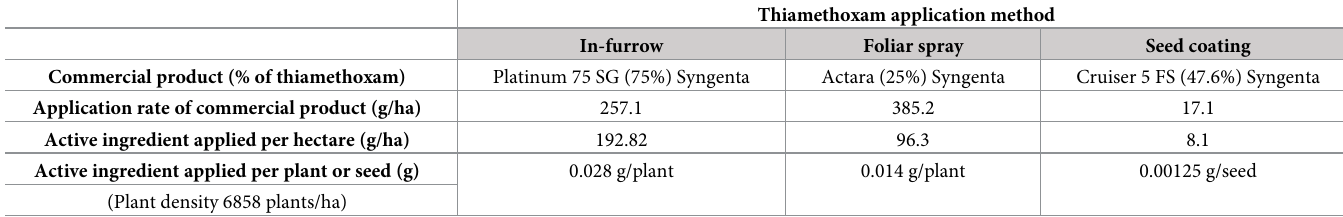
Table 1. Commercial products, product rates, and active ingredient rates used in the different thiamethoxam application methods